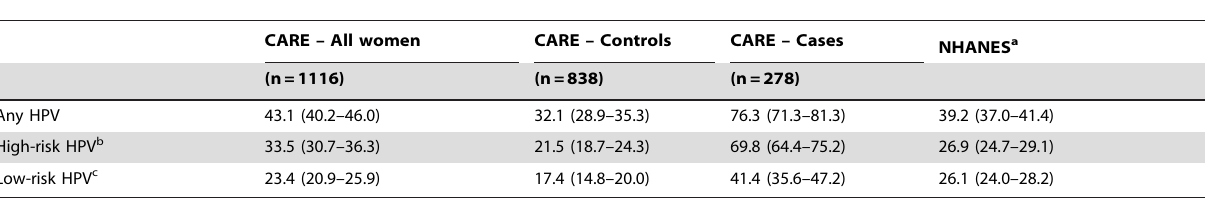
Table 2. HPV prevalence among women from the CARE Project and the NHANES.